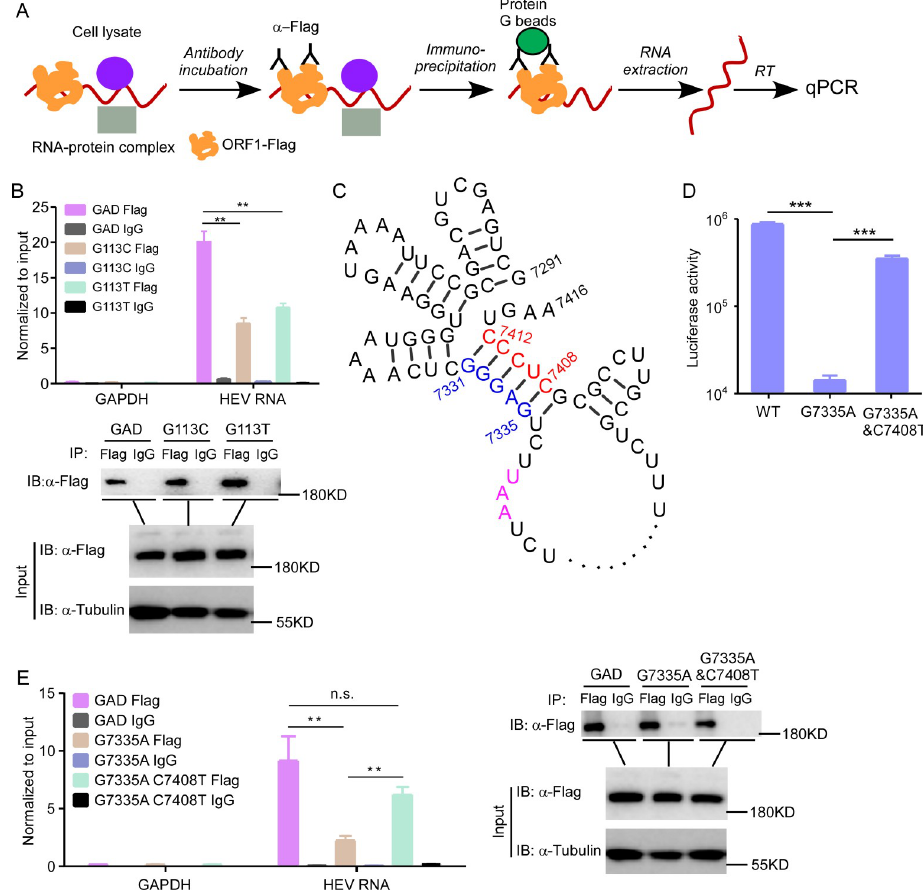
Fig 6. The cis -acting RNA elements interact with HEV ORF1. (A) A schematic representation of the RNA immunoprecipitation (RIP) assay used to examine the interaction of the HEV RNA genome with the ORF1 protein. (B) The 293T cells overexpressing ORF1 (GAD)-Flag were transfected with GAD or synonymous mutants of the viral genome. The cells were lysed and then incubated with Flag antibody to perform RIP with lgG as the negative control. The immunoprecipitated complex was subjected to RNA purification, and the ORF1-associated RNA were detected by RT-qPCR analysis. Enrichment of RNA binding to ORF1 is shown as fold normalized to input. Immunoblotting analysis was performed to confirm the efficacy of ORF1 (GAD)-Flag immunoprecipitation. GAPDH, glyceraldehyde- 3-phosphate dehydrogenase. (C) RNA structure prediction of the secondary structures of cis -acting RNA elements. RNAalifold [45] (http://rna.tbi.univie.ac.at/cgi-bin/RNAWebSuite/RNAalifold.cgi) was utilized to predict the secondary structures, suggesting that the G7335 would match C7408 to form the stem structure. (D) C7408T mutation restored the replication of the G7335A mutant. To verify the role of the stem structure in HEV replication based on this analysis, C7408T would restore the stem structure impaired in the G7335T mutant. Therefore, the C7408T mutation was introduced into G7335T mutant and the viral replicon RNA harboring the two mutations was transfected into HepG2C3A cells. The Gluc activity was measured as described previously. (E) RIP assay to analyze the association of G7335A mutant or G7335A/C7408T double mutant with HEV ORF1. This assay was performed as described in (B). Values are means plus SD (n = 3). �� , P < 0.01; ��� , P < 0.001; n.s., not significantly different by Student’s t test or one-way